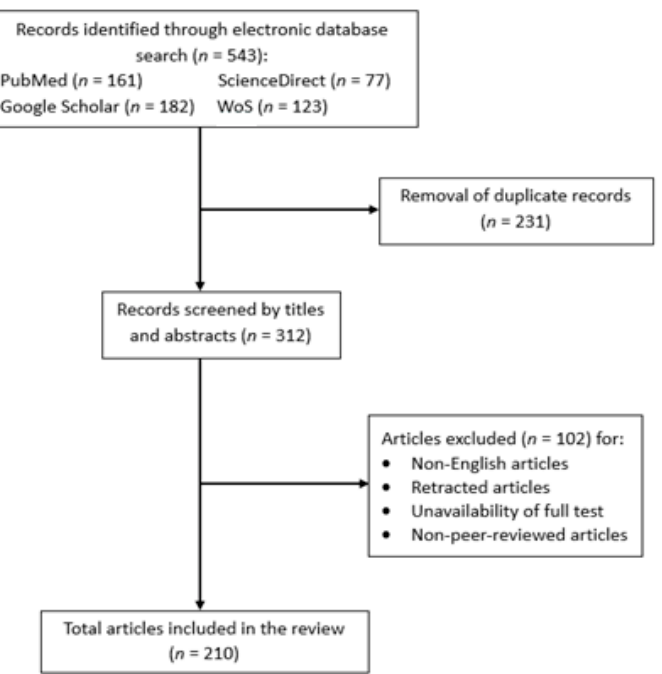
Figure 1. The preferred reporting items for systematic review and meta-analysis flowchart indicating the numbers of identified, screened, included and excluded articles in the